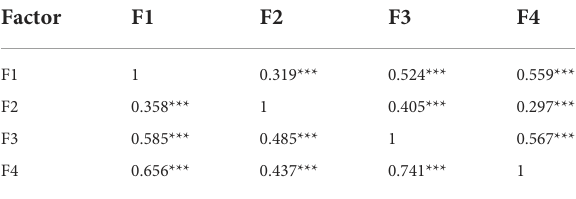
TABLE 3 Correlation between factors of the C19P-SC in CFA model and ESEM